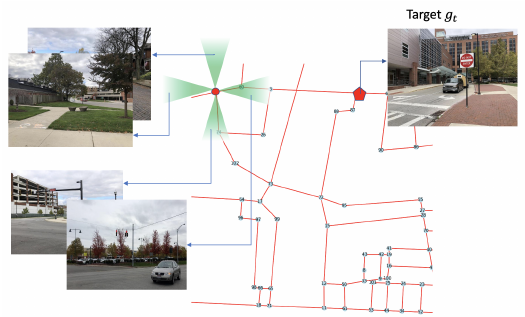
Figure 2. Discrete locations and agent’s observations at each